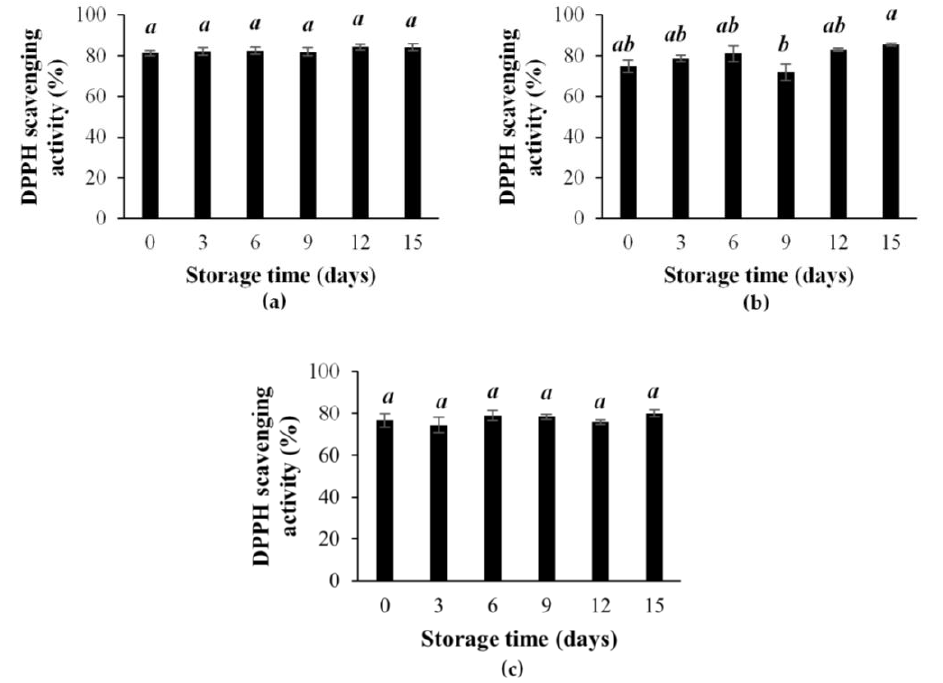
Figure 6. E ff ects of storage time on the DPPH scavenging activity of black tea: ( a ) 4 ◦ C, ( b ) 9 ◦ C and Figure 6. Effects of storage time on the DPPH scavenging activity of black tea: ( a ) 4 °C, ( b ) 9 °C and ( c ) 25 ◦ C. Means with the same capital alphabetical letters are not significantly di ff erent according to ( c ) 25 °C. Means with the same capital alphabetical letters are not significantly different according to the results of the Tukey’s the results of the Tukey’s test.